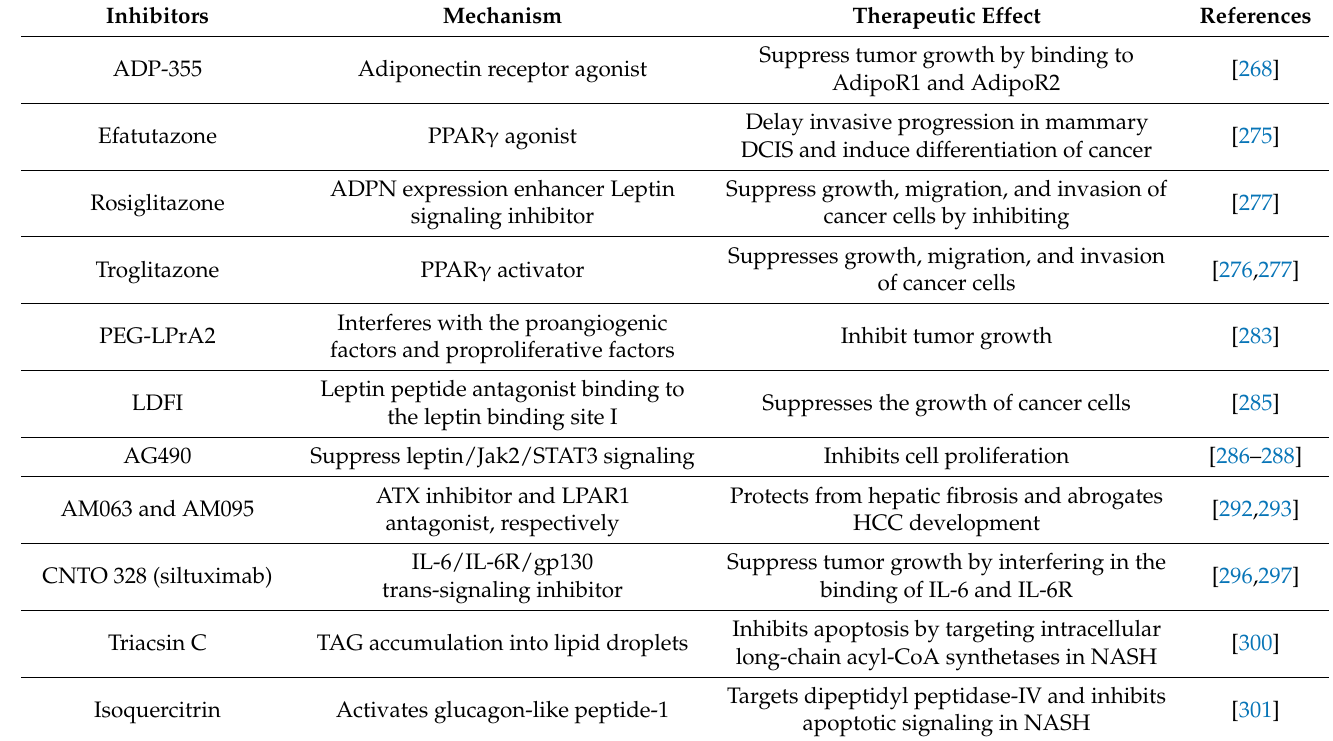
Table 3. Adiponectin and adipokines as therapeutic targets in